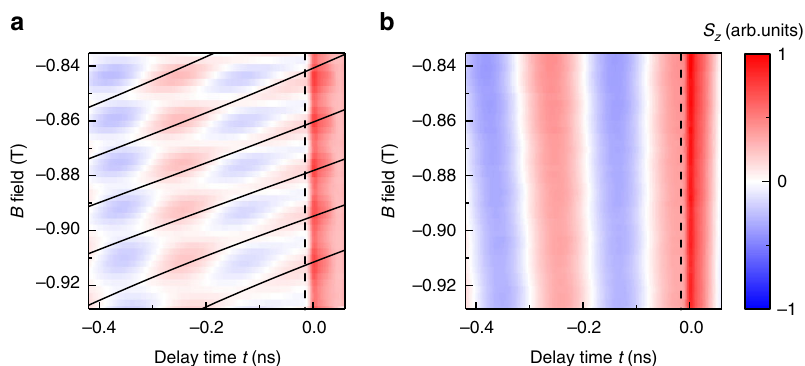
Fig. 2 Dependence on nuclear polarization. a Recorded S z ( t ) of a dot array (400 nm) immediately after depolarization of nuclear spins. The magnetic fi eld B is scanned from − 0.93 to − 0.83 T in 2.5 mT steps. Same normalization of S z is used in ( a , b ). The black lines mark the expected positions of constant phase where S z should attain maximum values in an unlocked spin system. b Signal from sixth scan, recorded 90 s after nuclear spins depolarization. The system is saturated and spin precession is mode-locked to the repetition rate of the laser, visible as a constant phase of the spin signal at t = − 15 ps (dashed